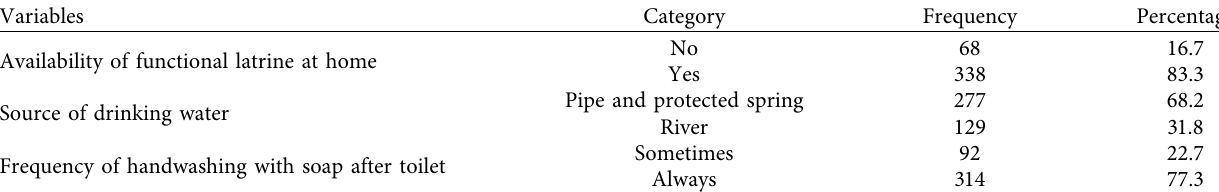
Table 2: Water and sanitation-related characteristics of adolescent students in Legehida district, Northeast Ethiopia, 2018. Variables